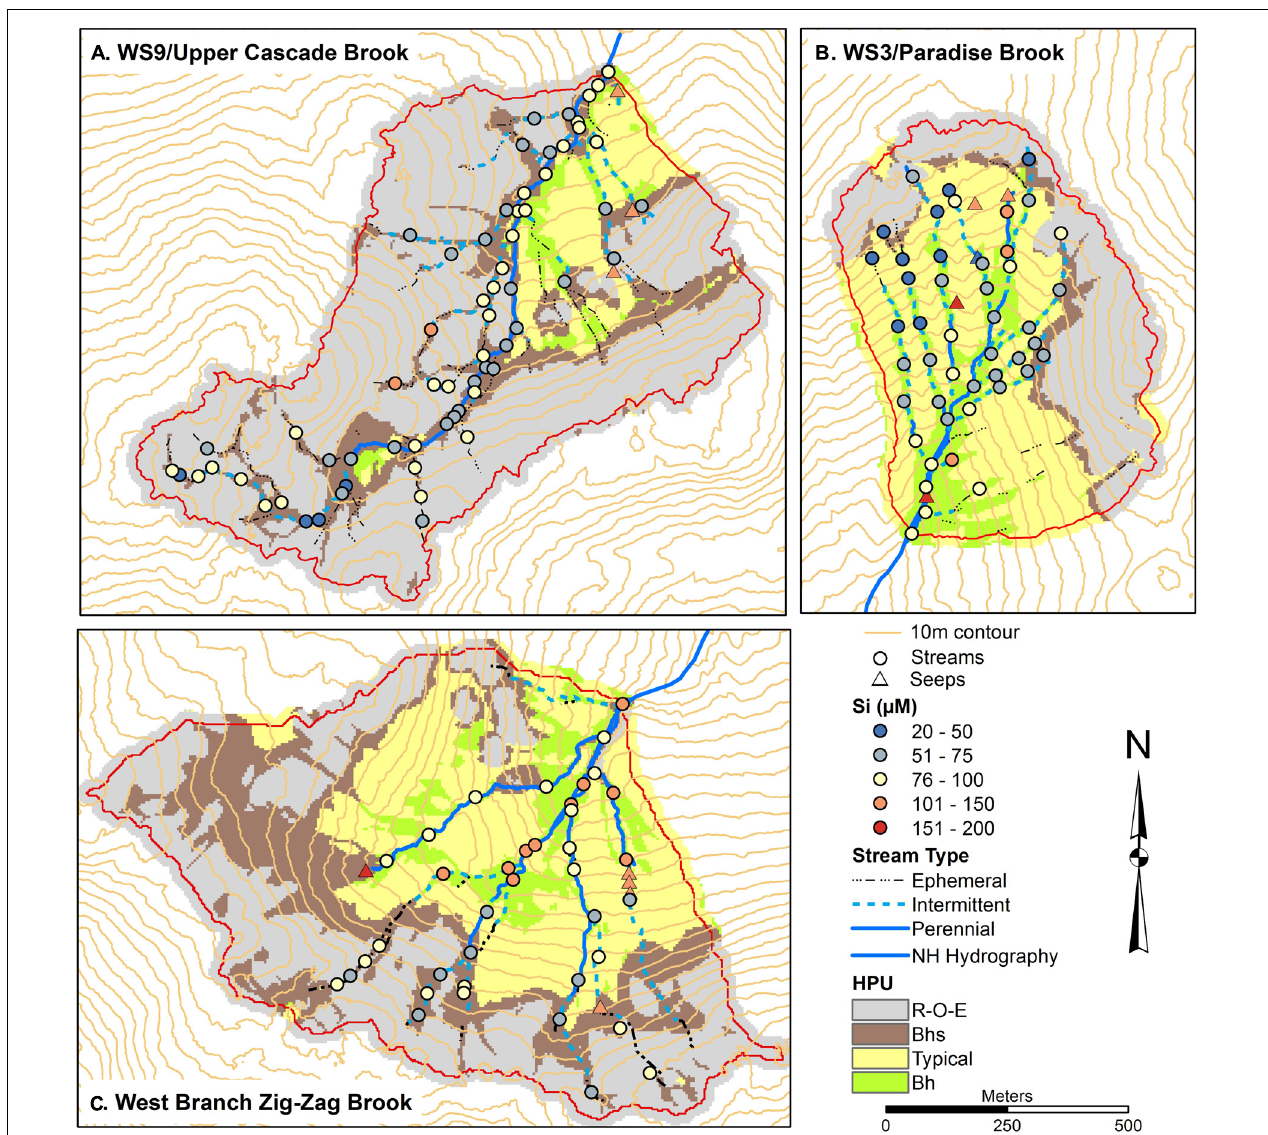
FIGURE 7 | Soils maps for W9 (A) , W3 (B) , and West Branch Zig Zag Brook (C) with variation in surface water silicon (Si) concentrations from a synoptic survey conducted July 22–23, 2015. Surface water samples were classified as streams (circles) or seeps (triangles). Soil units include bedrock outcrops, bedrock Histosols, and E podzols (R–O–E), Bhs podzols (Bhs), typical podzols (Typical), and Bh podzols